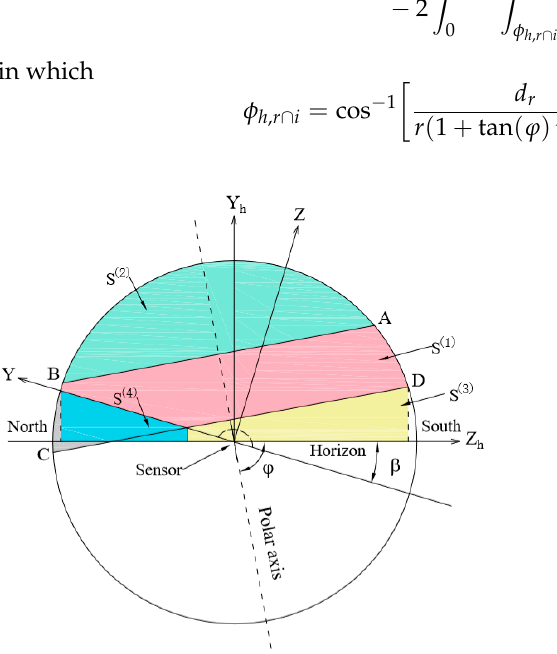
Figure 12, the axis Y is between the points A and B. T he Equation (5) can be written as